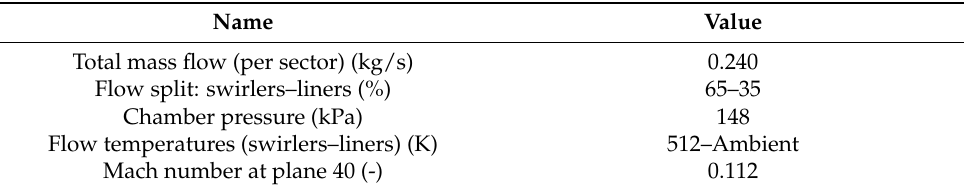
Table 1. Boundary conditions at multiperforated